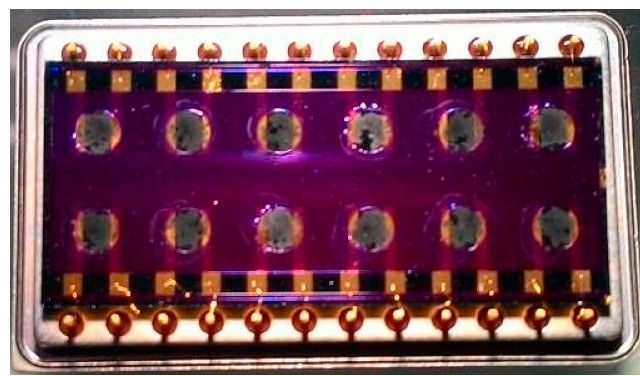
Figure 3. MWNT sensor array chip proposed by Wang et al. (Adapted from [92]).